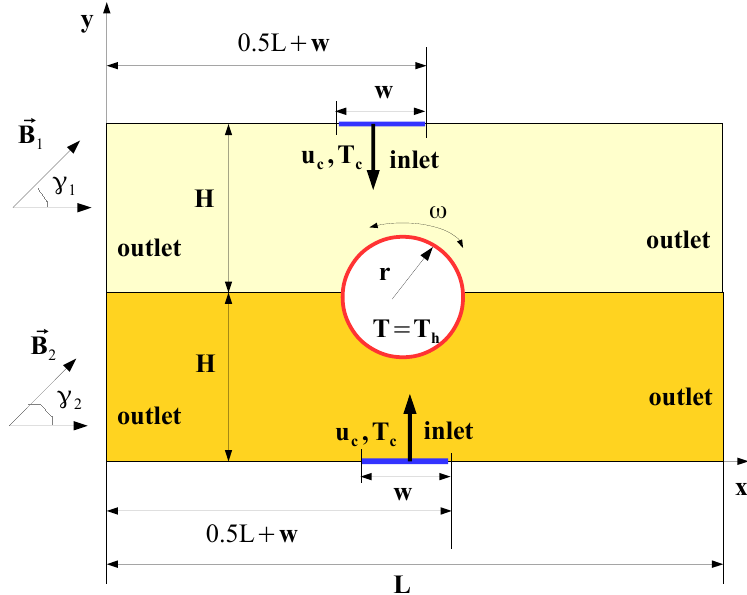
Figure 1. Model description with boundary